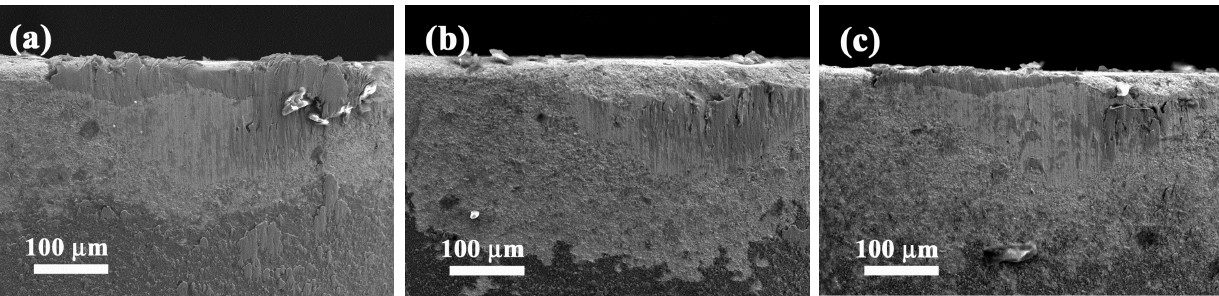
Figure 9. Maximum flank wear depths of uncoated, TiN, TiAlN, and (Al 0.34 Cr 0.22 Nb 0.11 Si 0.11 Ti 0.22 ) 50 N 50 coated inserts milling against 304 stainless steel as a function of cutting distance in the interrupted milling test.